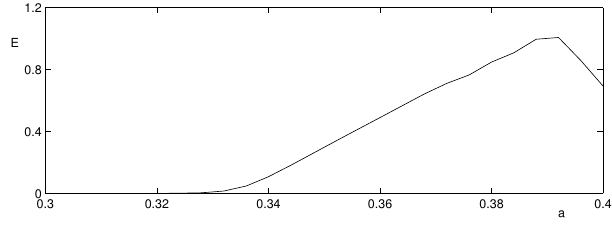
Figure 5. Error function D ( a ) for the Roessler